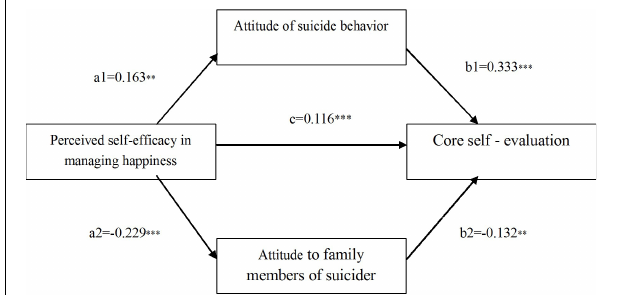
FIGURE 1 | Mediation effect diagram for attitude of suicide behavior and attitude toward family members of an individual who has committed suicide.